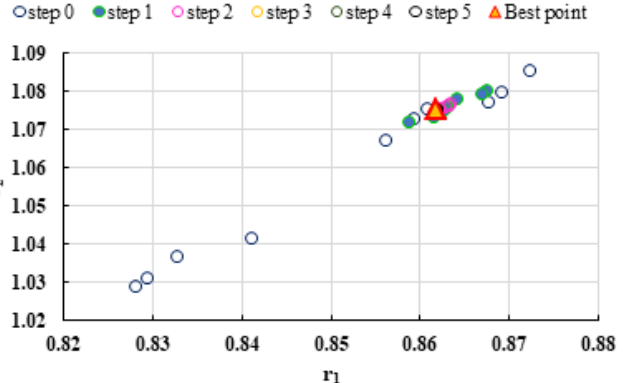
Figure 22. The JCR of analyzed methods for reactivity ratios calculation for copolymerization of Is-GMA [40].